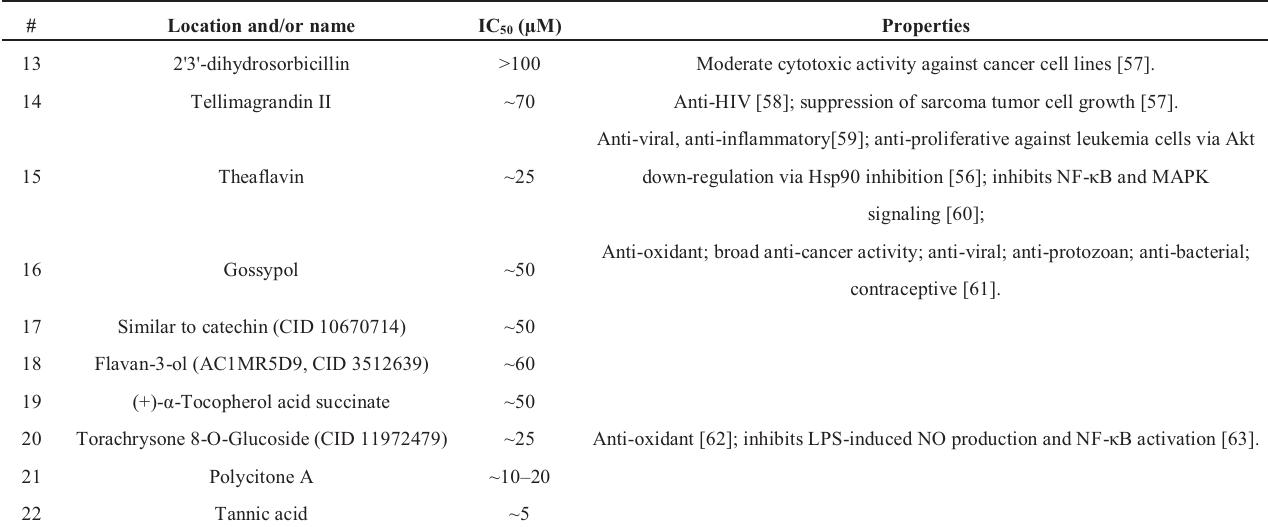
Table 2. Polyphenols and related